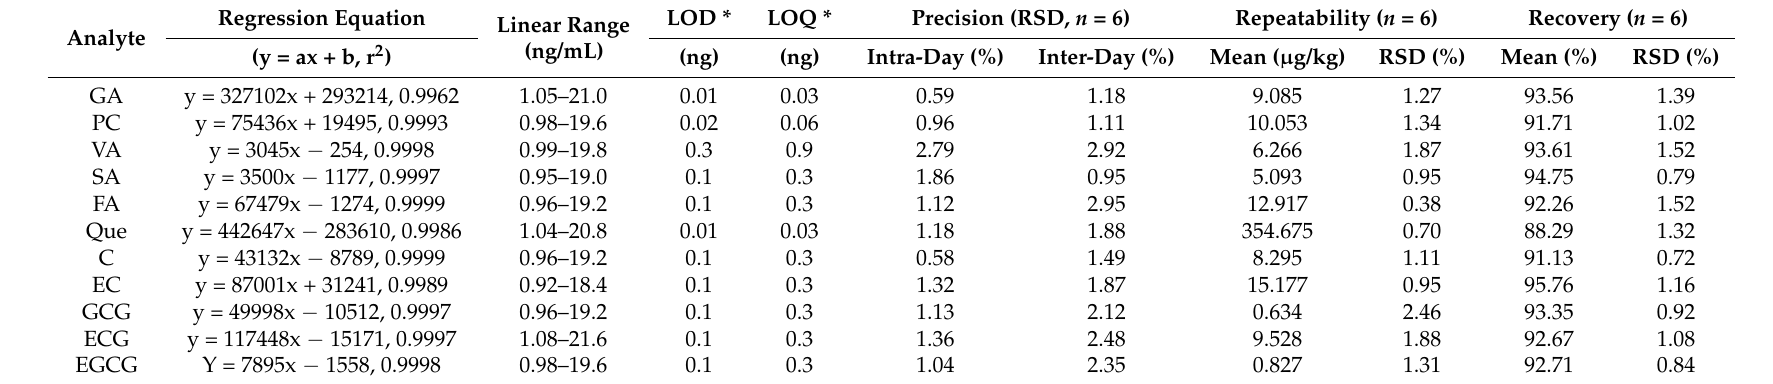
Table 3. The results of method